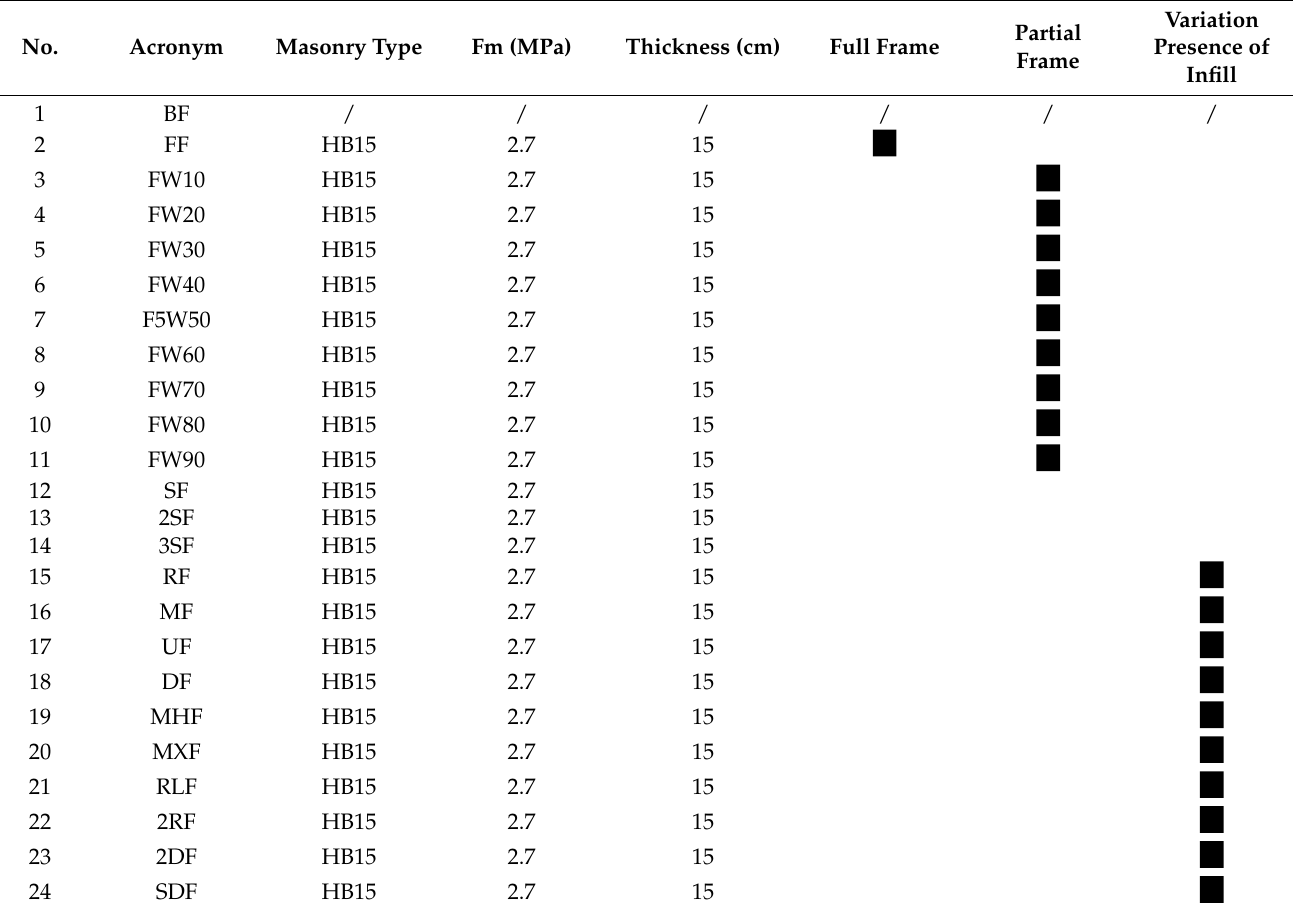
Table 3. Study summary.